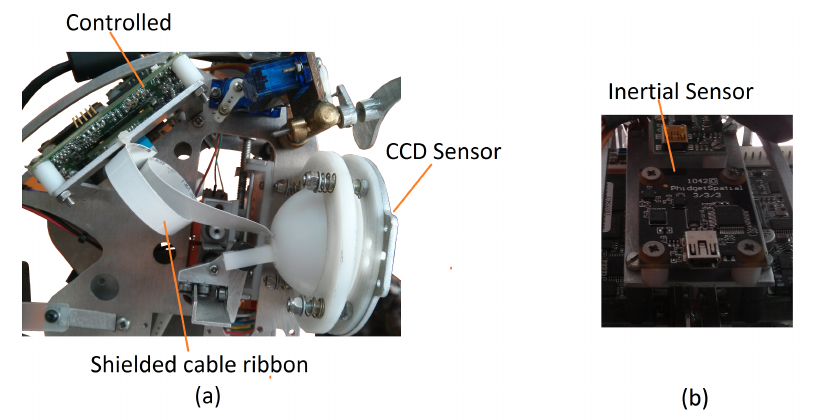
Figure 7. ( a ) Stereo vision system of Muecas; and ( b ) inertial